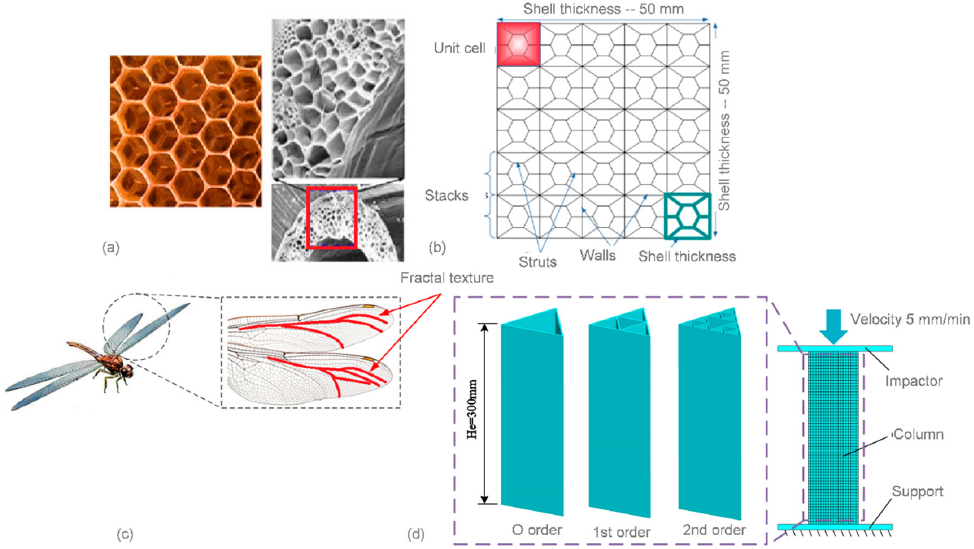
Figure 18. Bionic-inspired cellular structure design: ( a ) bee honeycomb pattern; ( b ) geometry of the cellular structure designed for numerical modelling [112]; ( c ) fractal texture of the wings of dragonflies; and ( d ) finite element model of the novel fractal structures [114].